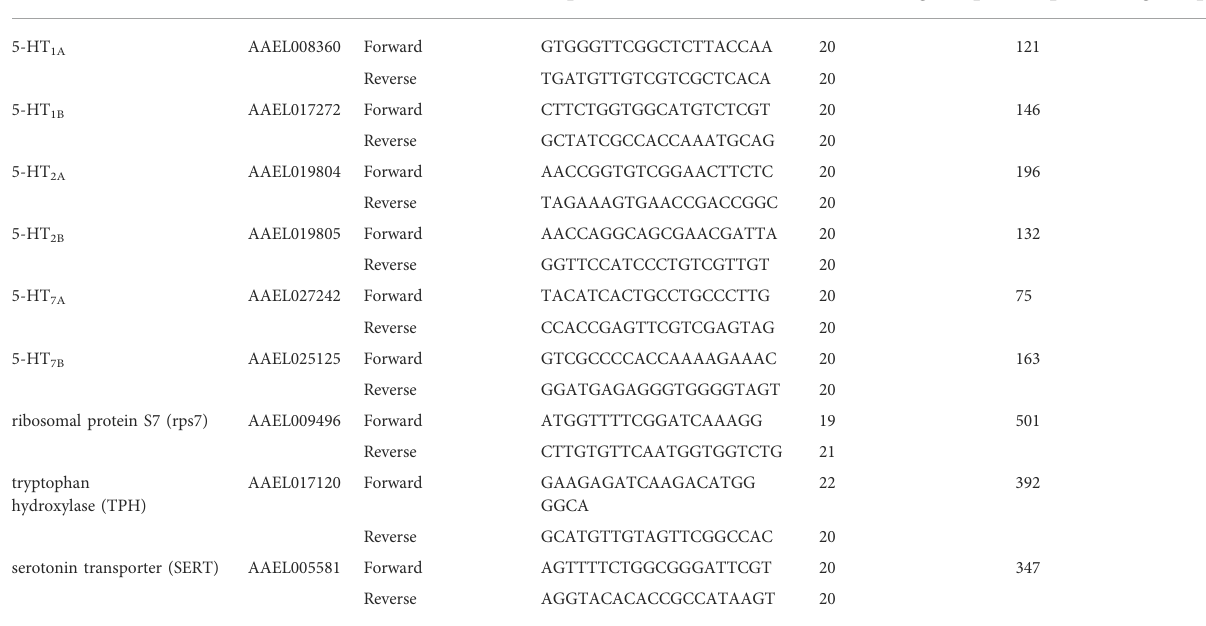
TABLE 1 Primer design for